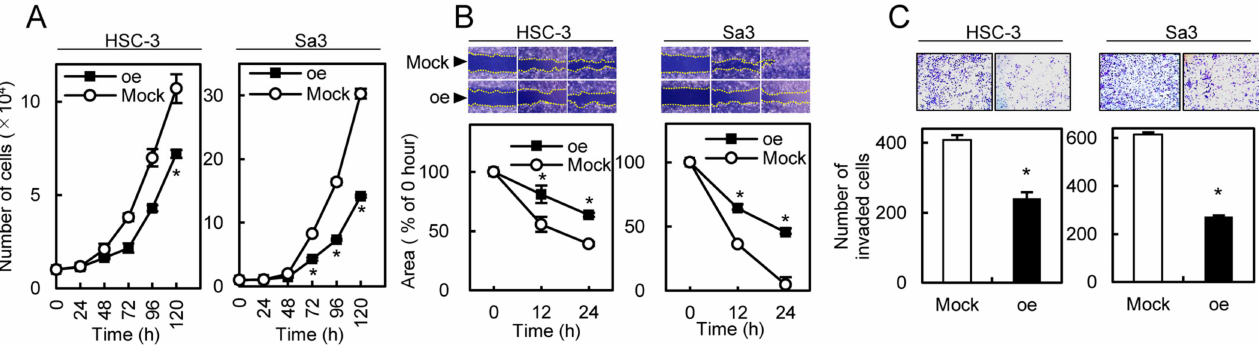
Figure 6. I Inhibitory effects of circRNA-102450 overexpression on the tumorigenic properties of OSCC cells. ( A – C ) The proliferation ( A ), migration ( B ), and invasion ( C ) of oe-circRNA-102450 and Mock cells ( n = 3). Data are expressed as means ± SD from triplicate analyses of three independent assays (* p < 0.05). oe, oe-circRNA-102450